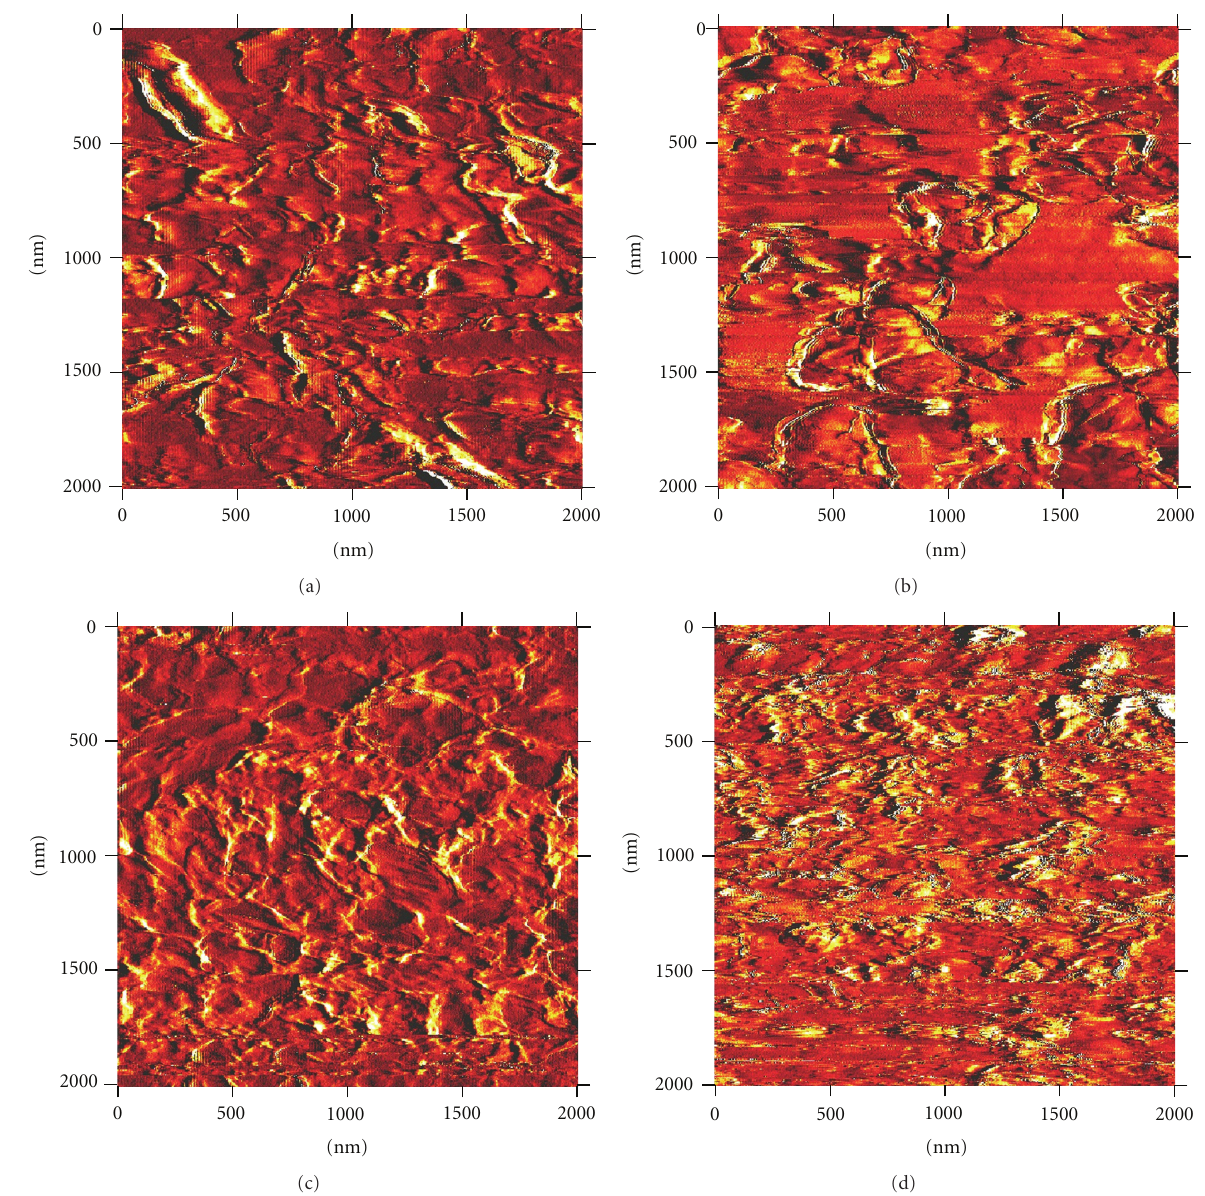
Figure 7: AFM phase images of PFE.BNDI (3:1) films annealed at di ff erent temperatures: (a) RT, RMS roughness: 11.2, (b) 40 ◦ C, RMS roughness: 10.4, (c) 60 ◦ C, RMS roughness: 7.5, and (d) 80 ◦ C, RMS roughness: 11.6.